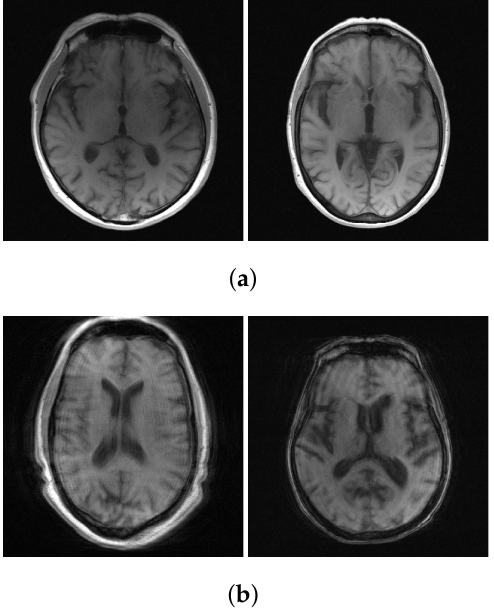
Figure 3. Examples of the NYU fastMRI brain dataset. ( a ) Artifact-free T1 weighted MR image; ( b ) Ringing artifact T1 weighted MR